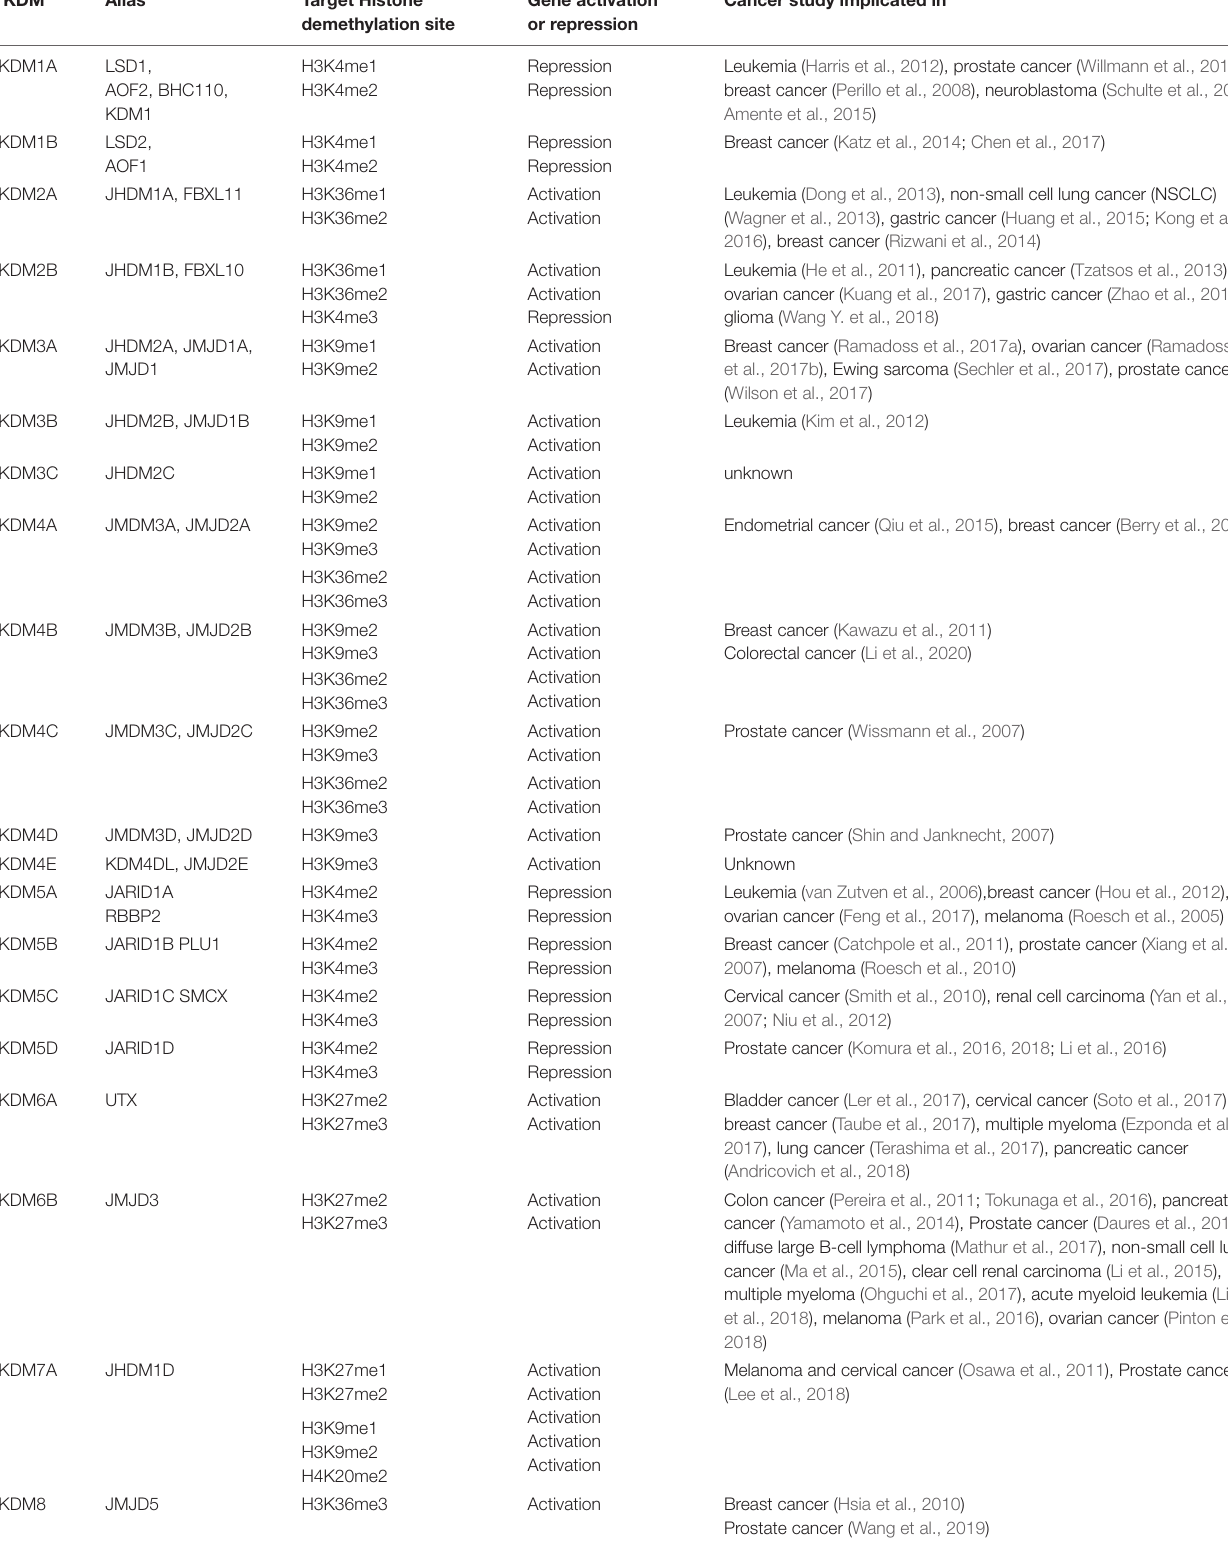
TABLE 1 | Summary of KDMs reported to be significant in